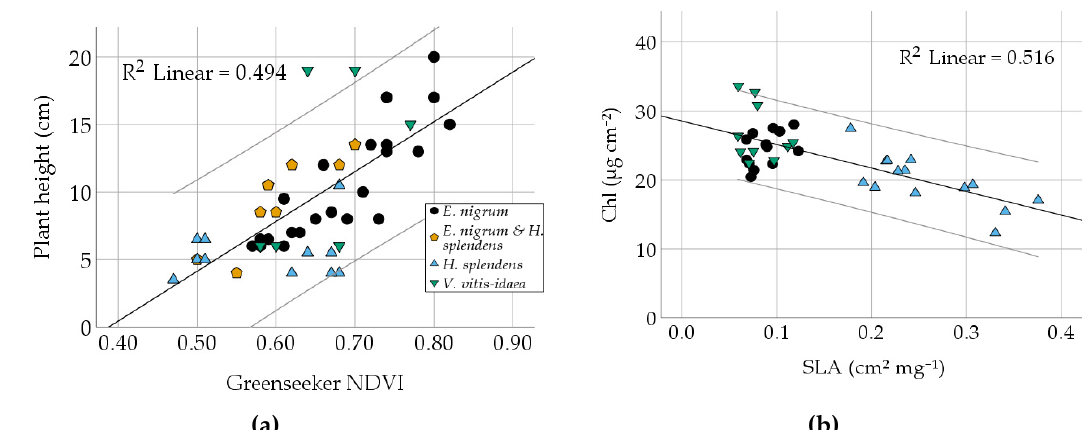
Figure 2. Relationship of two trait correlations from Table 4. Species are marked. 95% confidence intervals are grey. Relation between ( a ) median plant height and NDVI, ( b ) chlorophyll content and SLA. Equations and RMSE are shown in Table S4.